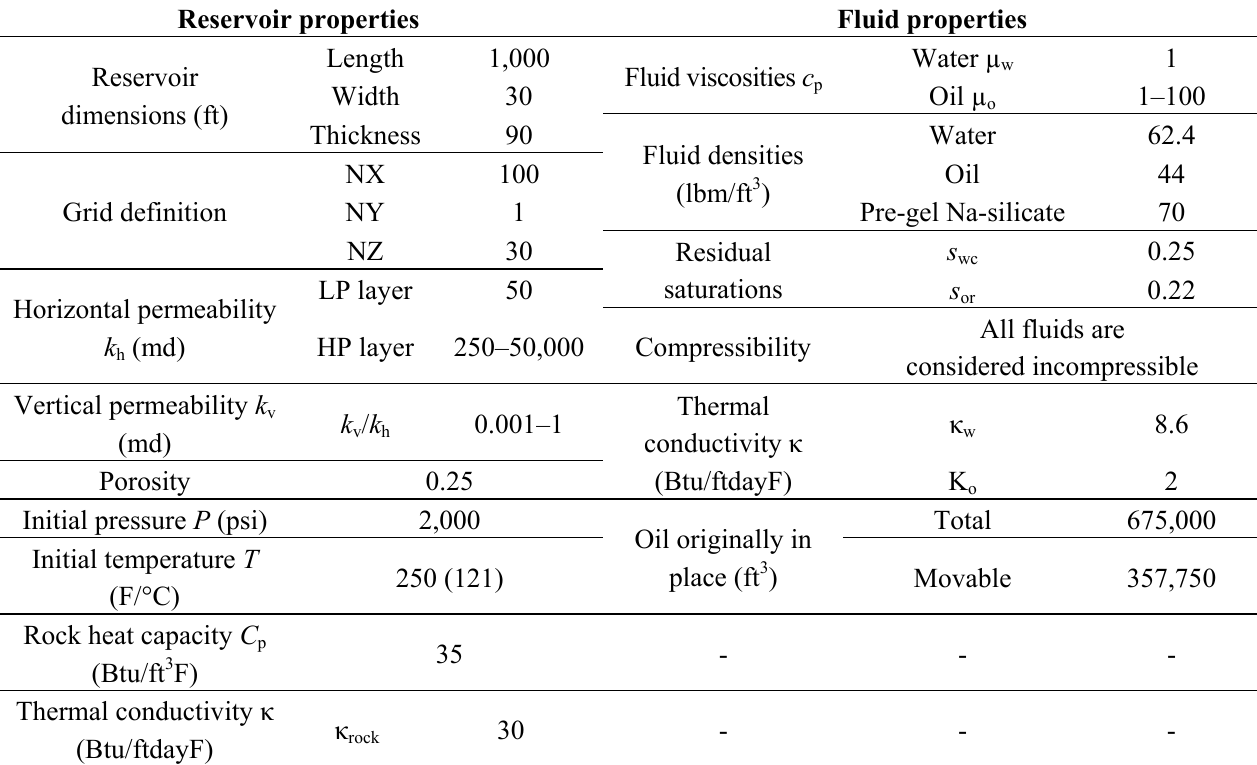
Table 4. Reservoir, fluid properties and computational parameters of the simulated two-layered reservoir model. LP: low permeability; and HP: high